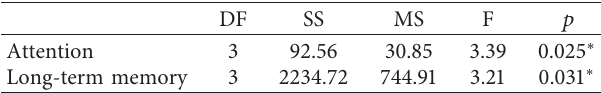
Table 2: ANOVA results of attention and long-term memory according to illuminance of LED